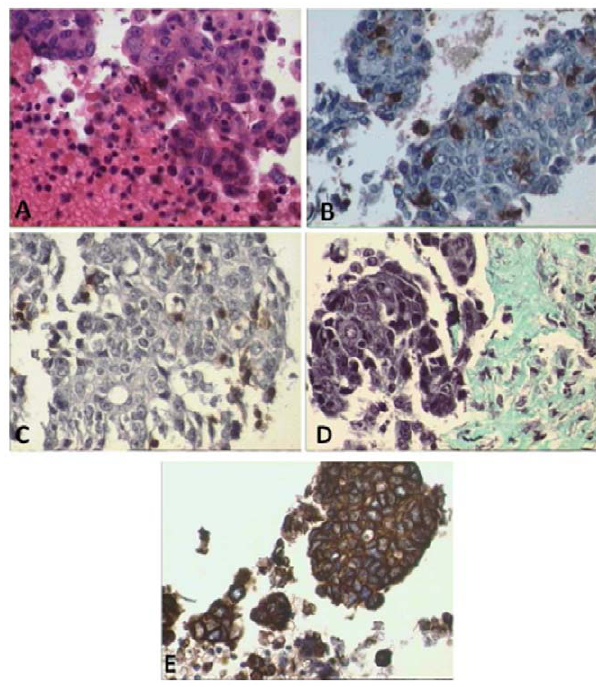
Figure 2. Presence of tumor, T cells and fibroblasts in tumor cell aggregates. Histology and immunohistochemistry of tumor- derived cell aggregates derived by mild disruption of a primary ovarian tumor. H&E staining show clusters of cells of different sizes (A) Immunohistochemical staining for human CD45 (B) and CD3 (C) shows evidence of human leukocytes and T cells, i.e. dark brown stained cells. Trichrome staining (D) reveals the presence of collagen which is produced by fibroblasts and stains aquamarine. Tumor cells stain dark brown with immunohistochemical stain for cytokeratin (E). All figures are at 400 6 magnification.